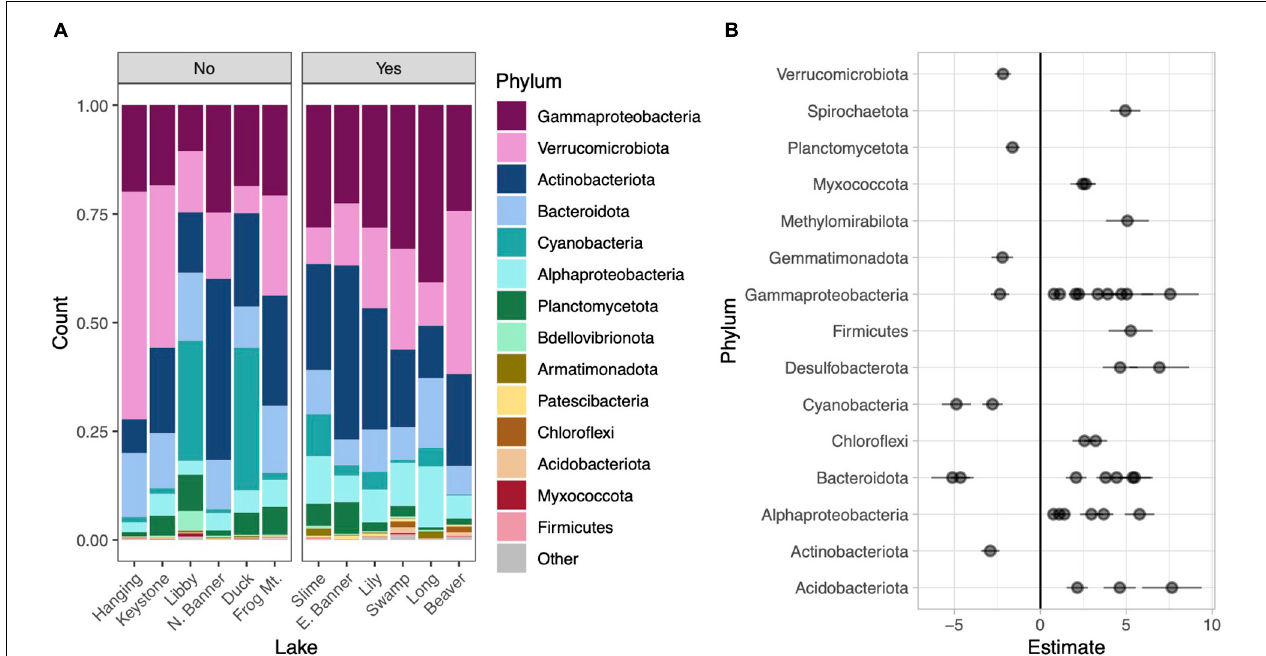
FIGURE 4 | Phylum level taxonomic composition in each lake. Lakes are divided into those without water lilies (No) and with water lilies (Yes). Lakes with water lilies are ordered from left to right from lowest to highest water lily surface coverage. Only phyla with mean relative abundance greater than 0.01% across all samples are included and the phylum Proteobacteria has been broken down by subphylum (A) . Beta coefficient estimates from the corncob regression model for differentially abundant families that met our three criteria: (1) significantly differentially abundant between lakes with none and many water lilies, (2) the effect of few and many water lilies was the same direction, and (3) the magnitude of the effect of many water lilies was greater than the effect of few water lilies. Negative estimates indicate taxa more abundant in lakes with no water lilies while positive estimates indicate taxa more abundant in lakes with many water lilies. Individual families are represented by points and are grouped by phylum (B)